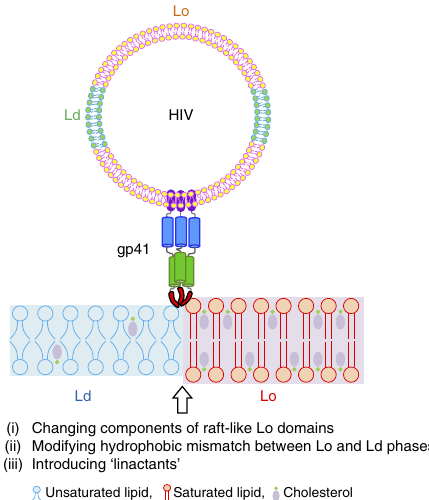
Figure 1 | Experimental design to study effects of lipid phase boundaries on HIVgp41-mediated membrane fusion. Schematic representation of HIV gp41 interaction with Lo/Ld domain phase boundary. The fusion peptide of gp41 preferentially inserts and promotes membrane fusion at the interface between Lo and Ld phases. To address what molecular and physical properties are responsible for membrane fusion at these boundaries, we systematically modulated the interfaces by changing components of the Lo domains, modifying hydrophobic mismatch and introducing line-active